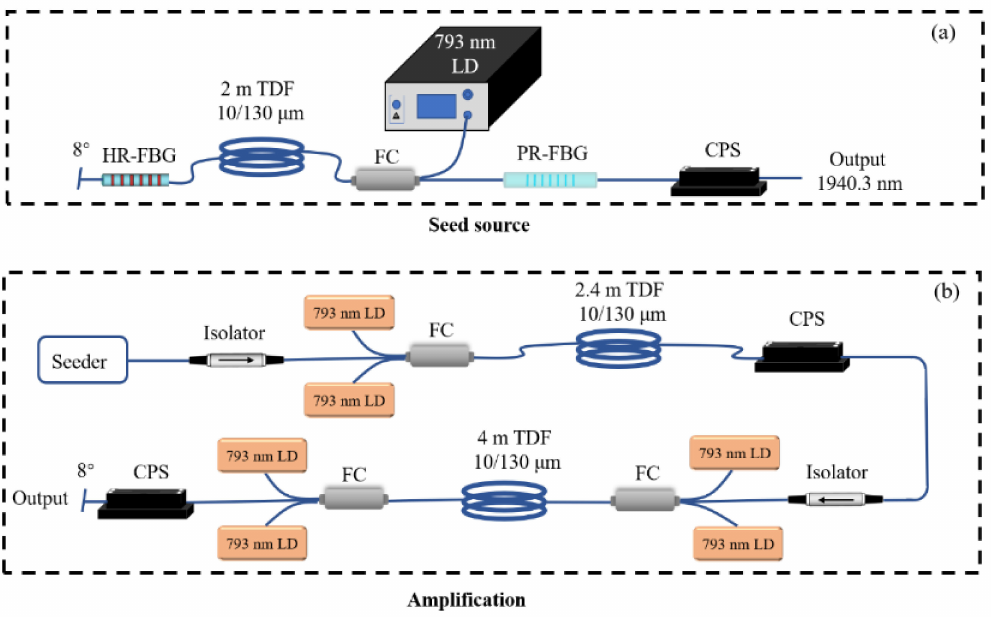
Figure 2. Schematic setup of the high-power narrow-linewidth thulium-doped all-fiber MOPA. ( a ) Seed source; ( b ) Amplification. HR: high-reflection, TDF: thulium-doped fiber, PR: partial reflec- tion, CPS: cladding power stripper, LD: laser diode, and FC: fiber